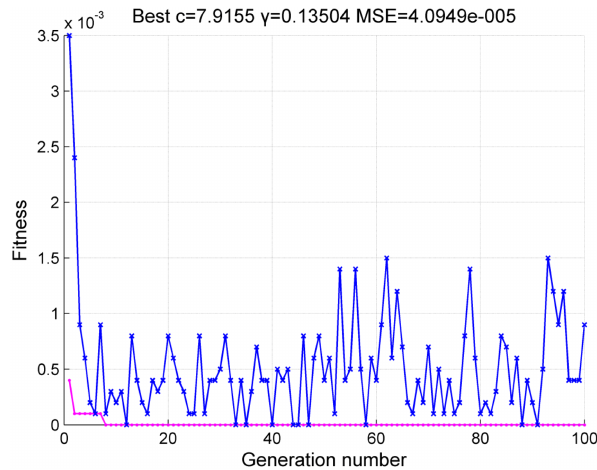
Fig. 6. The fitness curve of searching for the optimal parameters of the single-factor SVM by GA.